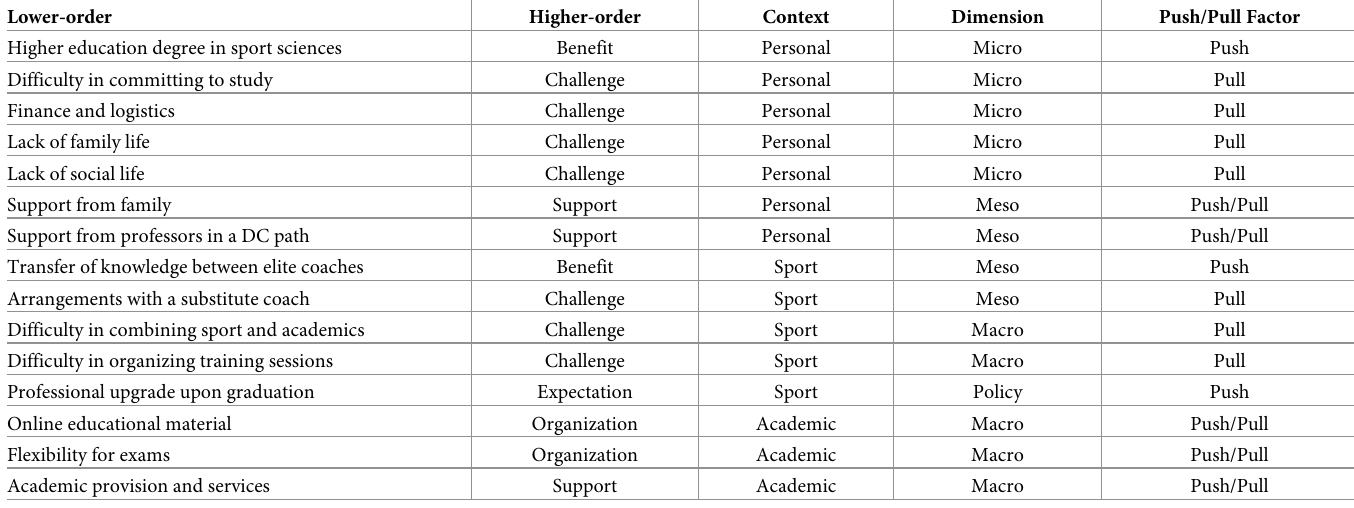
Table 3. Lower- and higher-order themes (e.g., benefit, challenge, expectation, organization, and support), organized in relation to the contexts (e.g., personal, aca- demic, and sport), and the dual career dimensions (e.g., micro, meso, macro, and policy).